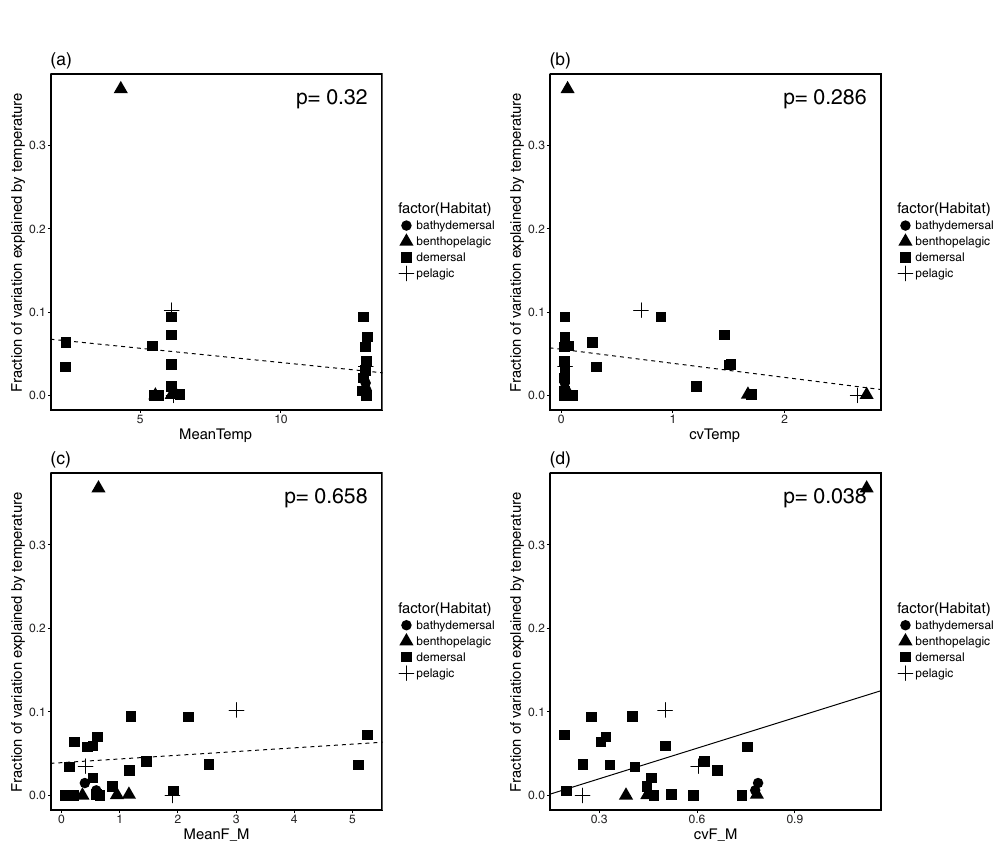
Figure 5. Explained variation by temperature in relation to the mean and CV of mortality ratio or temperature. The line is the best-fitted regression line based on the linear mixed effect model with each fishing/temperature index as fixed effect and habitat as random effect. The solid line indicates the significant result ( d